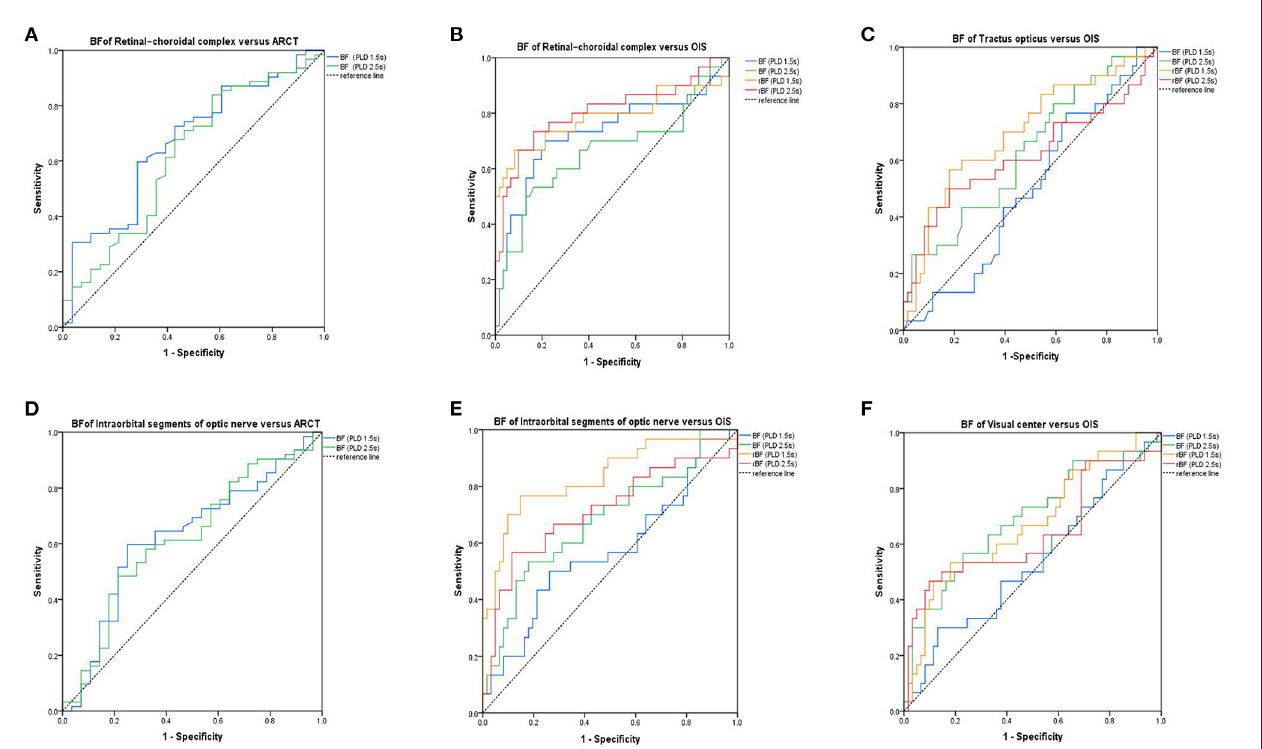
FIGURE4 Receiver operating characteristic curves. The area under curve (AUC) showing the accuracy of the values of blood flow perfusion in the visual pathway, identified using arterial spin labeling (ASL) for diagnosis of the delayed retinal arterial filling (A, D) . The AUC shows the accuracy of the values of blood flow perfusion in the visual pathway, identified using ASL for diagnosis of OIS (B, C, E, F) . BF, blood flow; rBF, relative blood flow; ARCT, arm-retinal circulation time; OIS, ocular ischemic